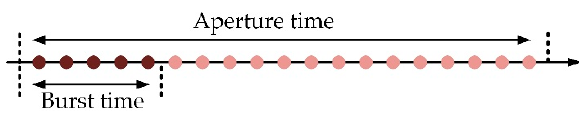
Figure 4. Traditional scanning method.